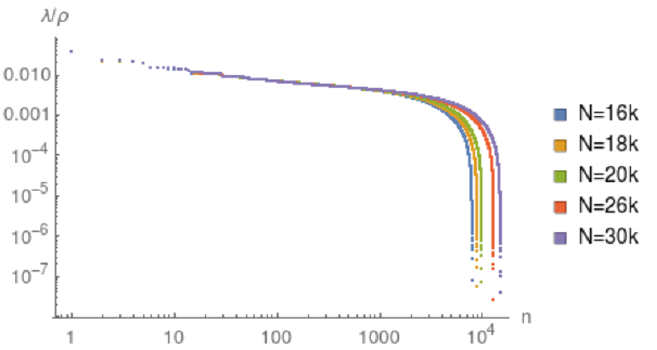
Figure 6. Log-log plot of the eigenvalues of i (cid:1) divided by density (cid:26) , in the 4d causal diamond; m = 0.